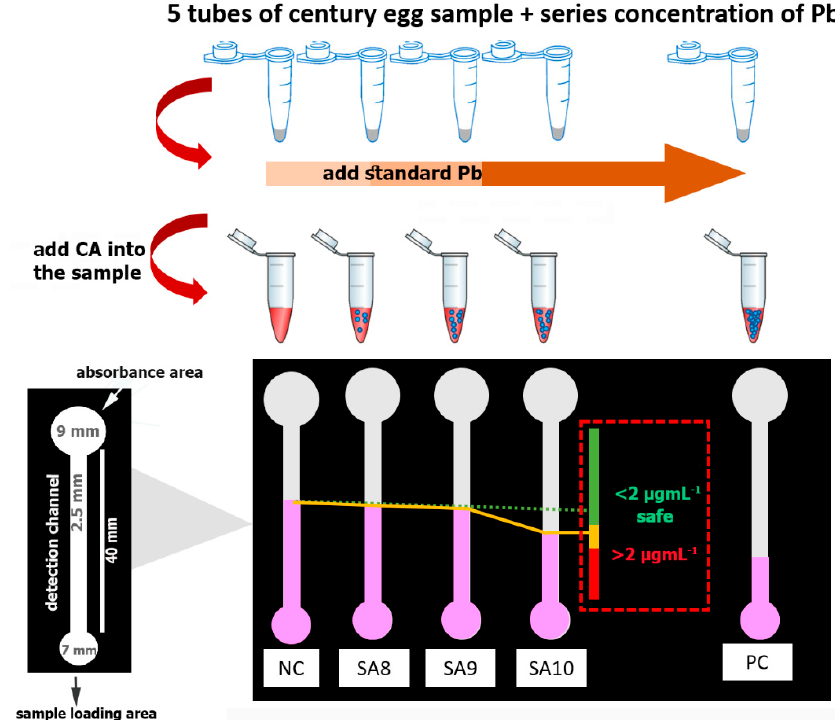
Figure 1. Demonstration of the screening analysis of lead (Pb) in century egg samples using the developed distance paper-based analytical device (dPAD) combined with the standard addition technique for evaluation at the cutoff concentration of Pb. CA, carminic acid. NC, negative control; SA8, SA9, and SA10, sample with standard Pb addition at the concentration of 8, 9, and 10 µ g · mL − 1 , respectively; PC, positive control.